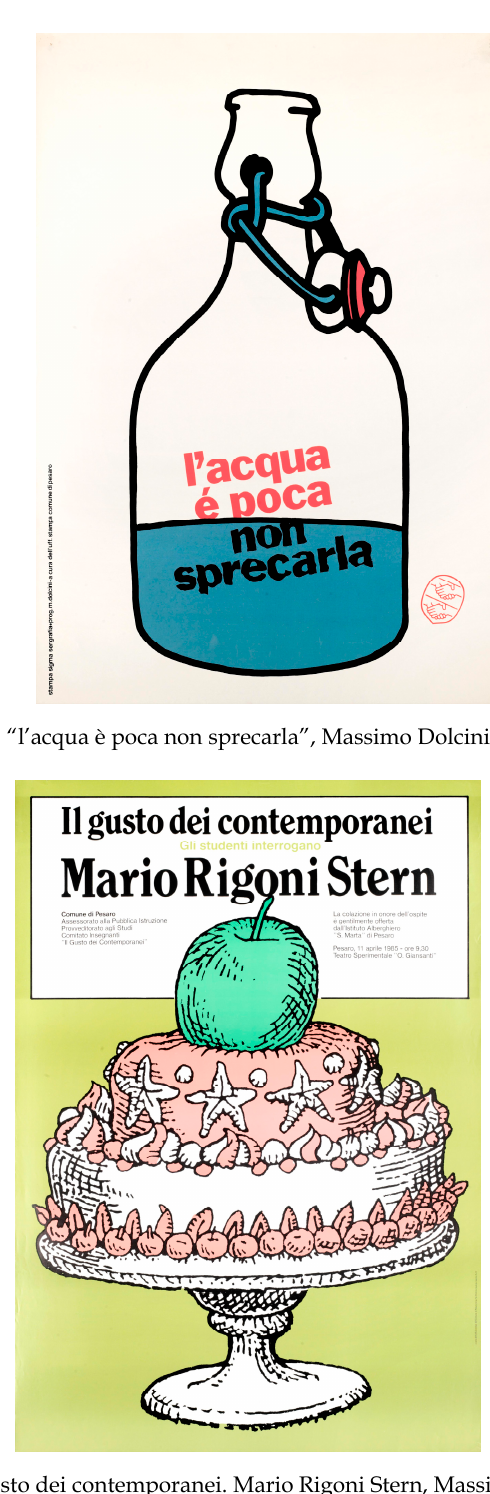
Figure 5. “Il gusto dei contemporanei. Mario Rigoni Stern, Massimo Dolcini, 19